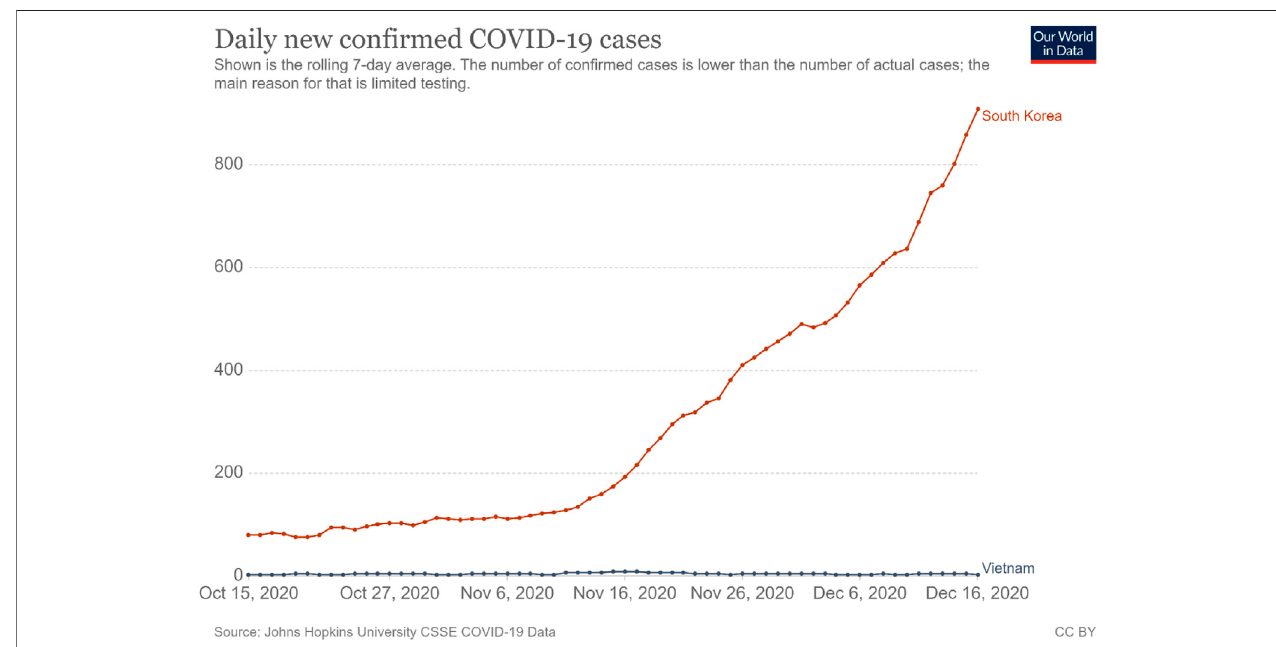
FIGURE 3 | COVID-19 con fi rmed deaths in vietnam and the RoK between 15 October 2020 and 15 December 2020 (see Ritchie, et al., 2020).